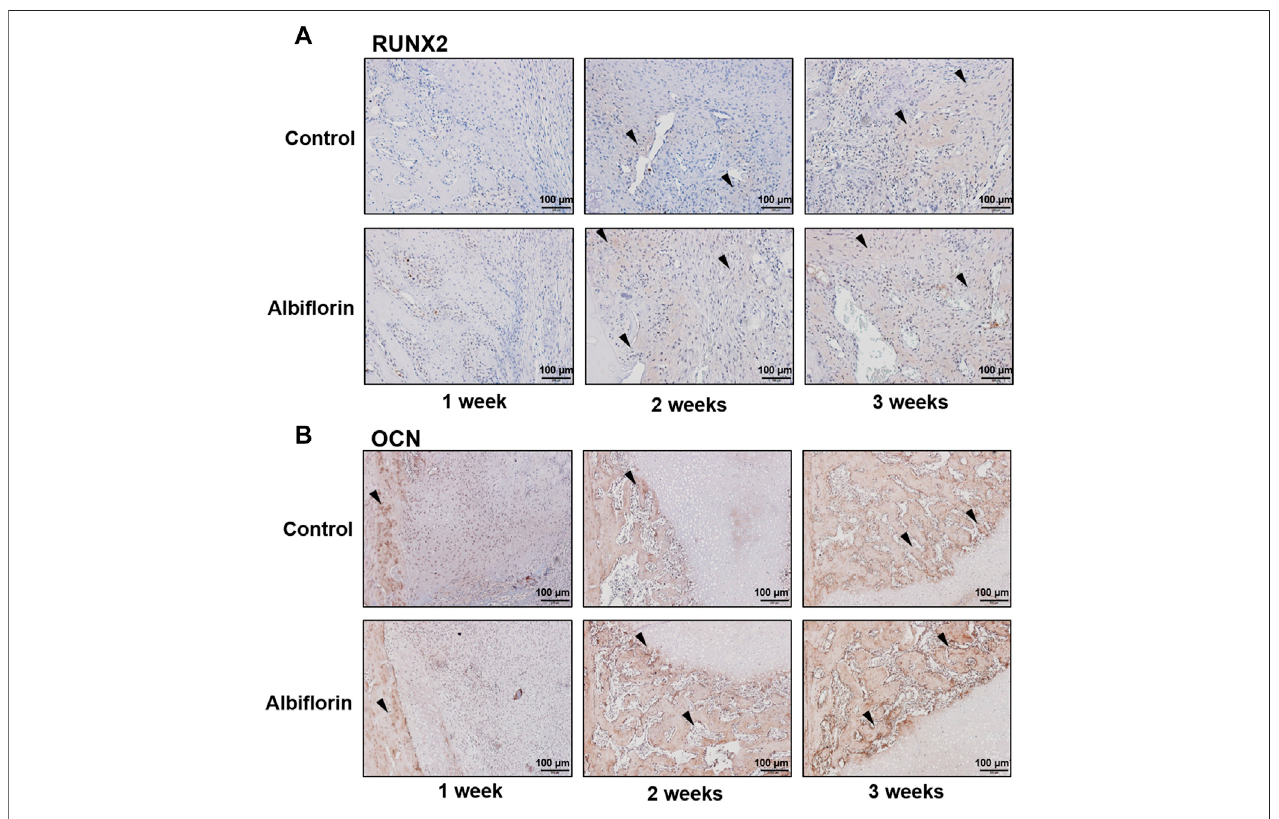
FIGURE 11 | Effect of albi fl orin on bone formation indicators in femoral tissue (A) Expression of RUNX2 in femoral tissue was analyzed by IHC staining (magni fi cation: × 200, scale bar: 100 µm) (B) OCN protein expression at femoral tissue was also measured by IHC staining (magni fi cation: × 200, scale bar: 100 µm).